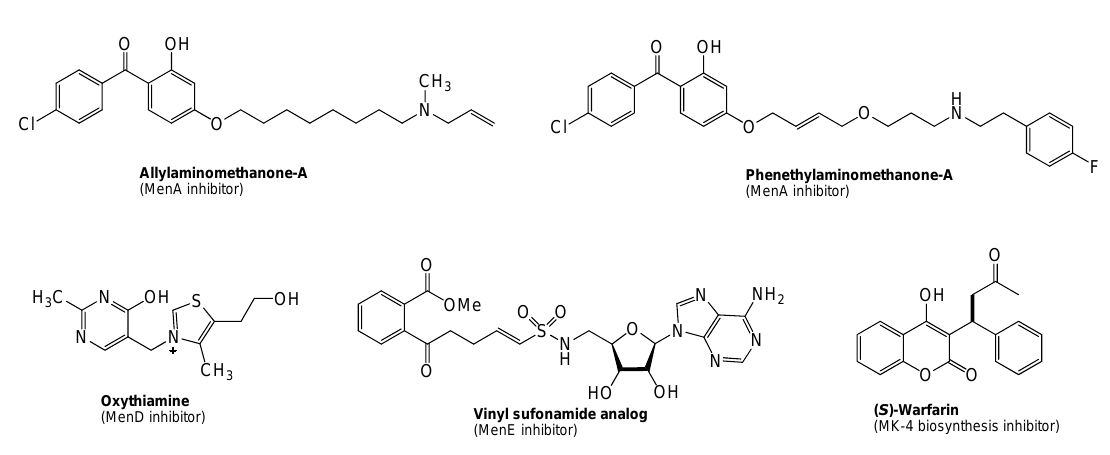
Figure 8. Representative menaquinone biosynthesis